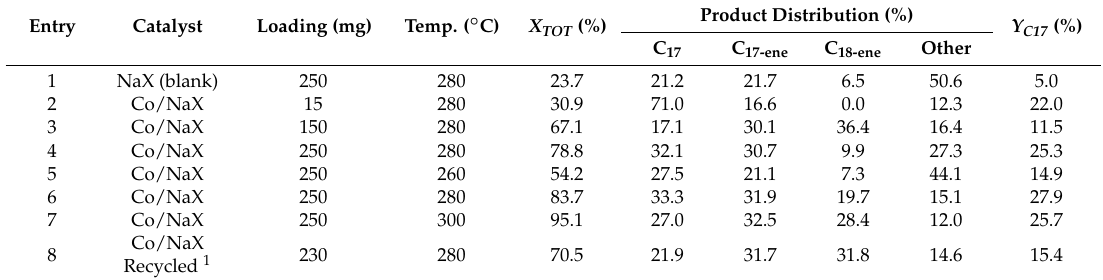
Table 2. Product distribution for the deoxygenation of stearic acid over Co/NaX catalyst in N 2 .